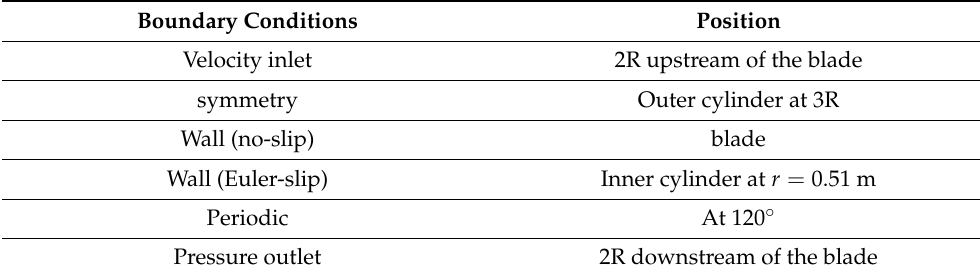
Table 2. Boundary